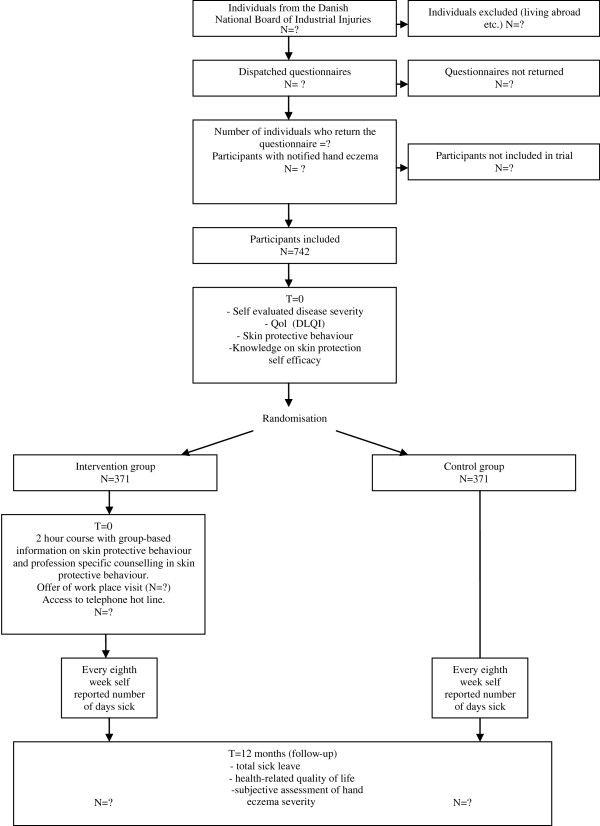
Trial flowchart.